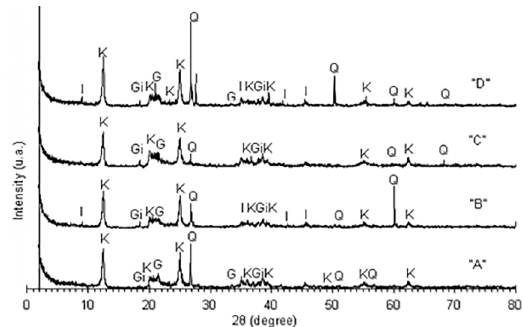
Figure 2. X-ray diffractogram of clays A, B, C, D